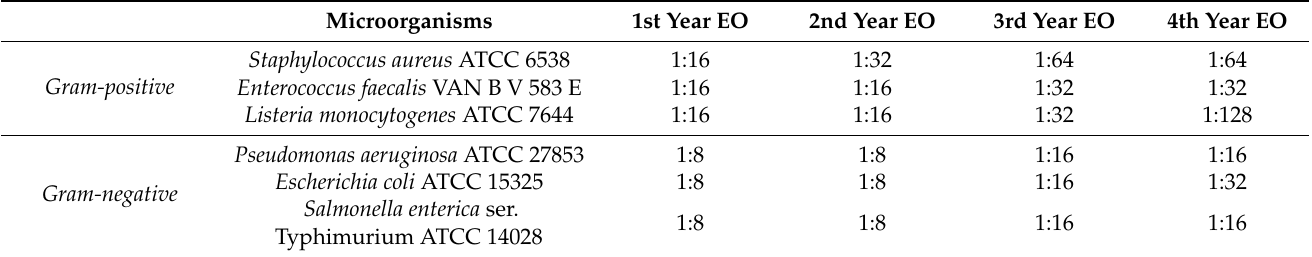
Table 4. Mode of minimum inhibitory concentration (MIC) of lavender essential oils (EOs) against the tested ATCC microorganisms.